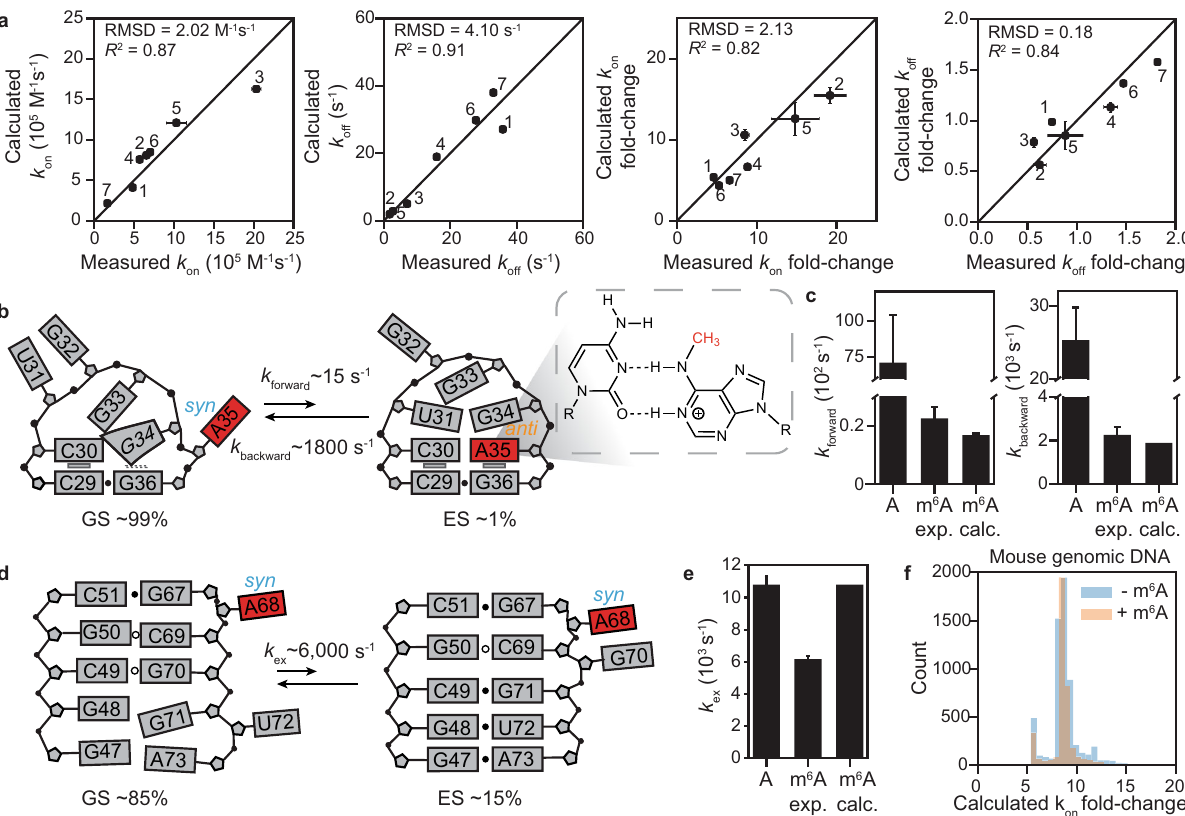
Fig. 6 Testing the predictive power of the CS + IF model. a Comparison of experimentally measured and predicted apparent k on , k off , and the fold-change relative to unmethylated duplex ( k on fold-change = k on (unmethylated)/ k app and k off fold-change = k off (unmethylated)\ k app ) for RNA and DNA on ; m 6 A off ; m 6 A duplexes. Each point corresponds to a different duplex and/or experimental condition. All buffers contained 40 mM Na + , unless stated otherwise: (1) dsGGACU m 6 A at T = 65 °C, (2) at T = 55 °C, (3) with 3 mM Mg 2 + at T = 65 °C; (4) dsHCVm 6 A with 3 mM Mg 2 + at T = 60 °C, (5) with 3 mM Mg 2 + at T = 55 °C, (6) with 3 mM Mg 2 + and 100 mM Na + at T = 60 °C; (7) dsA6DNA m 6 A at T = 50 °C. Similar correlations were observed using RD simulation- based prediction method shown in Supplementary Fig. 9b. b Secondary structures of GS and ES in the apical loop of HIV-TAR with m 6 A35 (highlighted in red), showing the chemical structure of the m 6 A + -C bp. c Comparison of k forward and k backward for unmethylated TAR (A), experimentally measured (m 6 A exp.) and predicted (m 6 A calc.) for methylated TAR. d Secondary structures of GS and ES of methylated RREIIB. e Comparison of k ex of unmethylated RRE (A), experimentally measured (m 6 A exp.), and predicted (m 6 A calc.) for methylated RRE. f Predicting the m 6 A-induced slowdown effect on k app of 12- on ; m 6 A mers (see “ Methods ” ) for m 6 A sites 9 (orange) and random DNA (blue) in the mouse genome. Data in panels ( a , c , e ) were presented as mean values ±1 s.d. from Monte Carlo simulations (number of iterations = 500) for one CEST measurement as described in “ Methods. ” Source data for panels ( a , c , e ) are provided in the Source Data fi